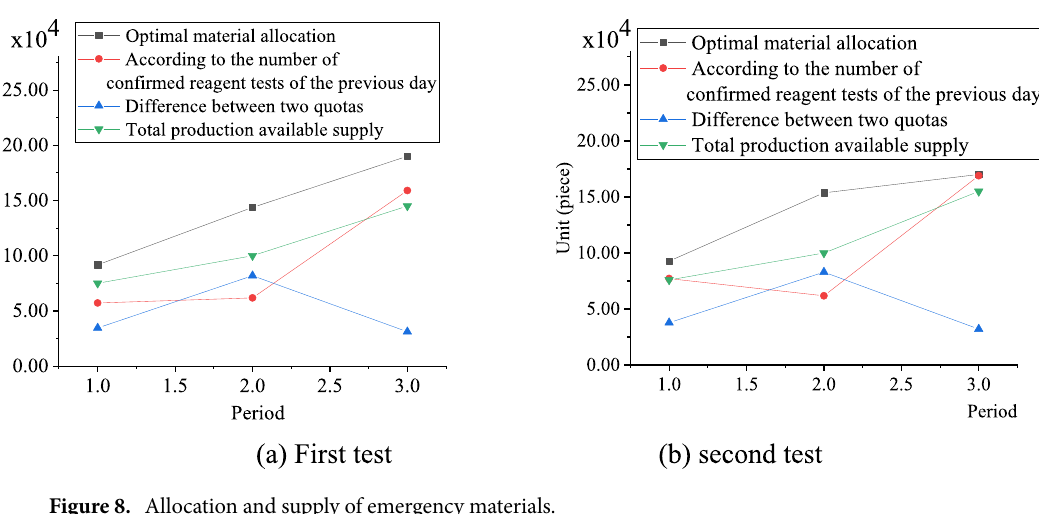
Figure 8. Allocation and supply of emergency